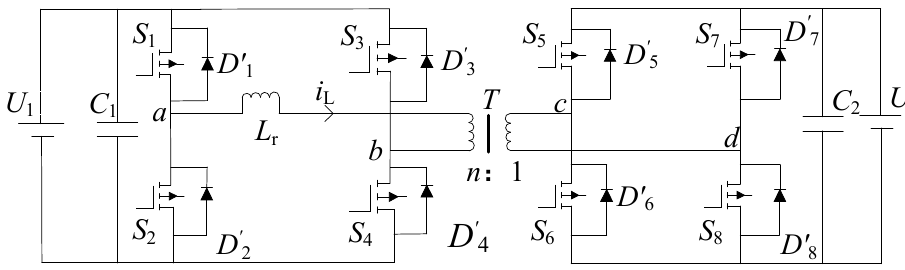
Figure 1. DAB topology.